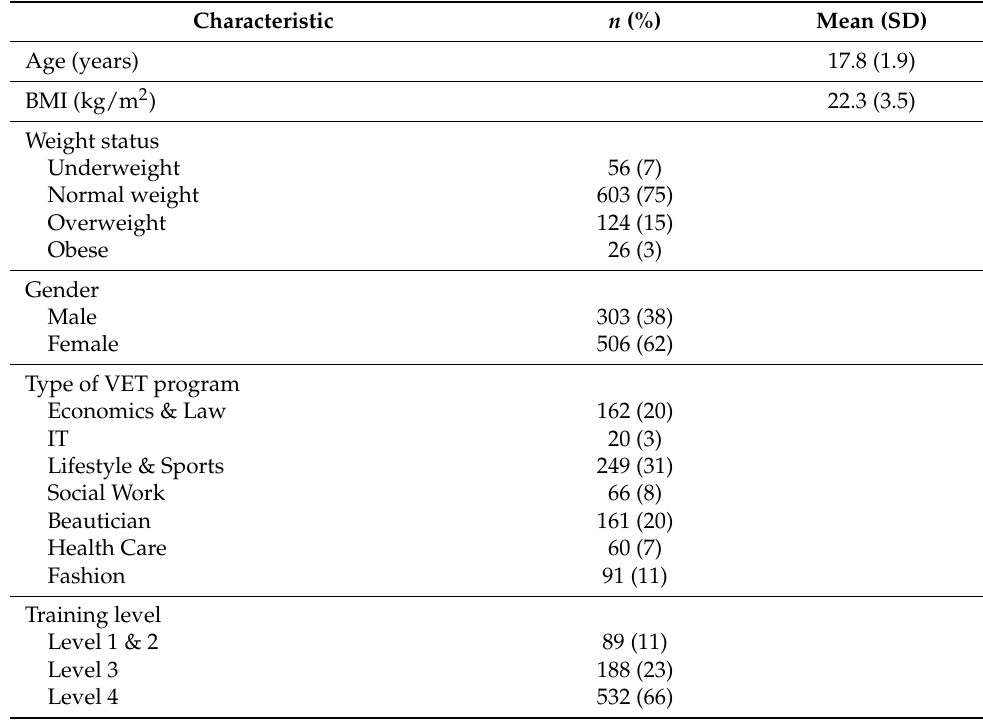
Table 1. Individual characteristics as a percentage of the sample (N = 809) or means and standard de- viations.